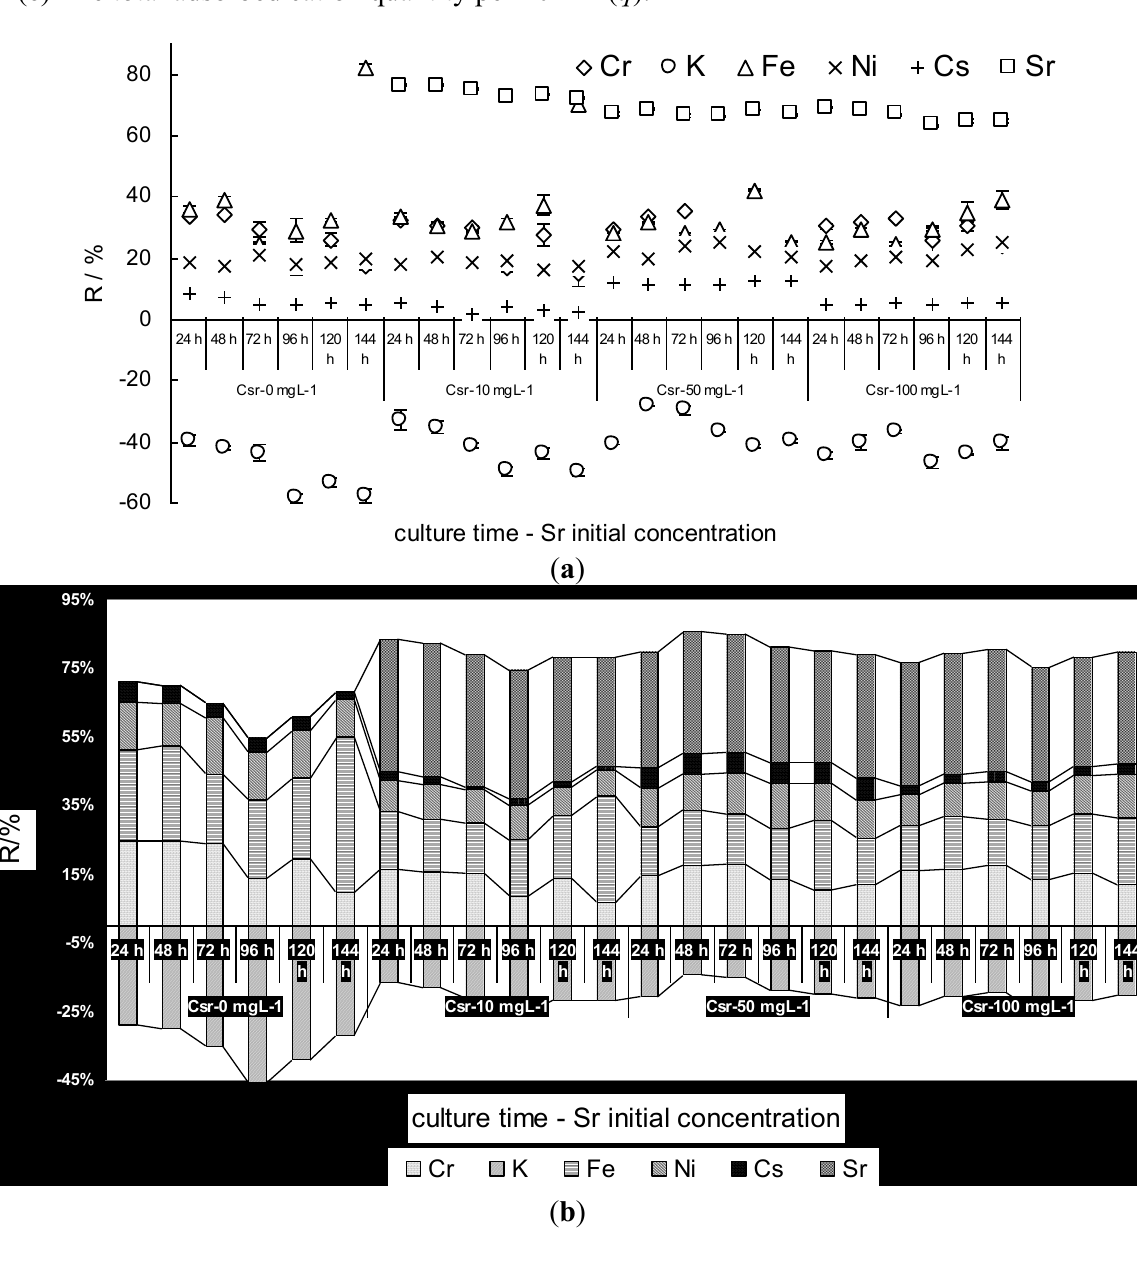
( R ); ( b ) The packing arrangement figure of adsorbed cation quantity per 10 mL ( q ); ( c ) The total adsorbed cation quantity per 10 mL ( q